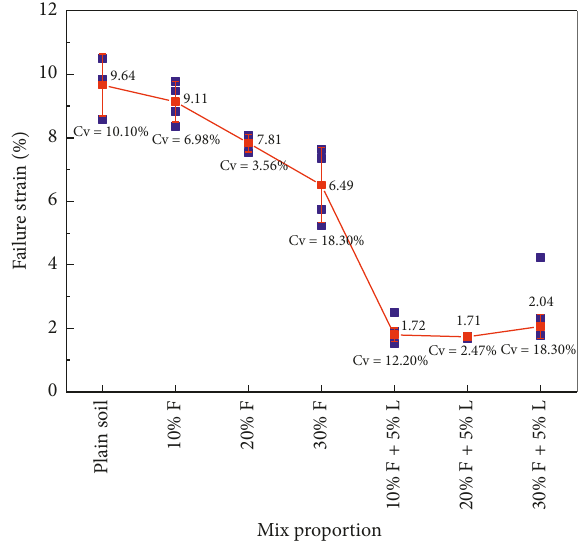
Figure 11: Unconfined compressive failure strain curve of stabi- lized soil (7